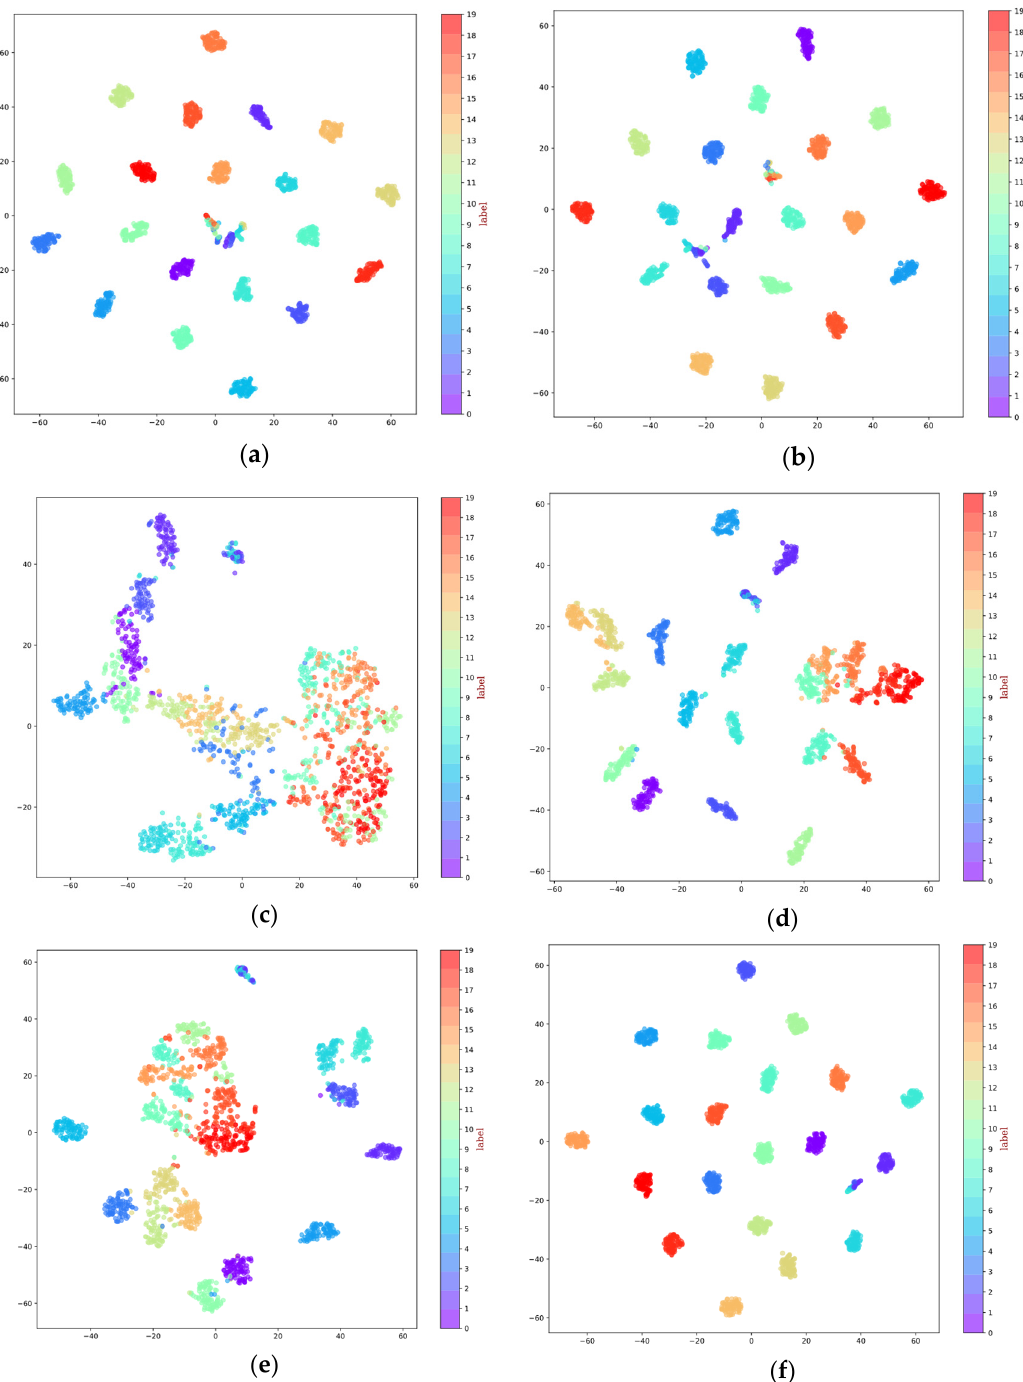
Figure 12. Visualization of features from the output layer for SEU_B dataset: ( a ) visualization results for AE, ( b ) visualization results for DAE, ( c ) visualization results for CNN, ( d ) visualization results for AlexNet, ( e ) visualization results for LSTM, ( f ) visualization results for proposed method.